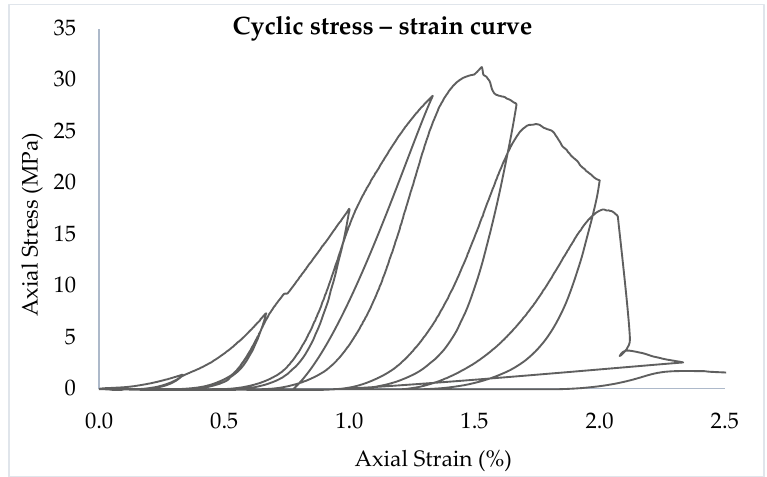
Figure 12. Axial stress versus axial strain curves of C-C0S2B2 concrete cylinder confined with epoxy-based HSBFRP under cyclic axial load.